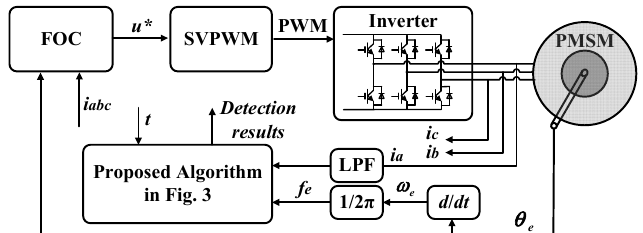
Figure 5. Overall control block.